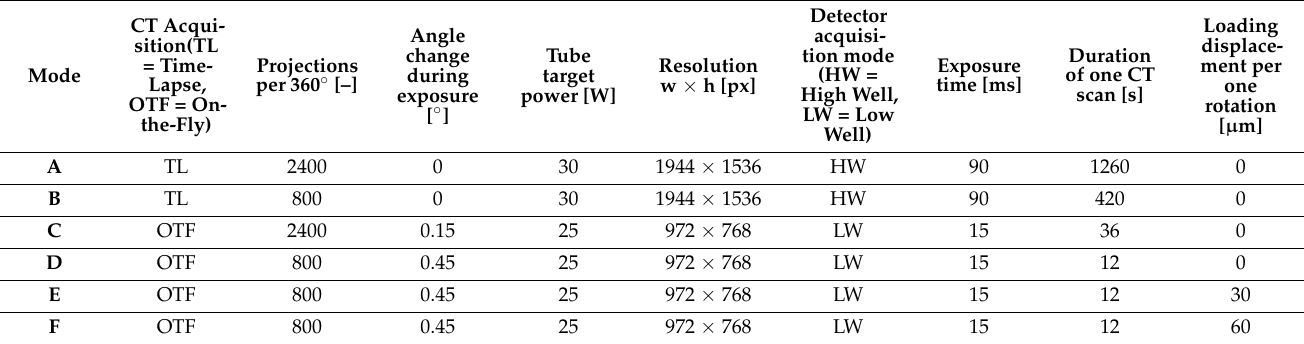
Table 1. Parameters of the six investigated acquisition modes.